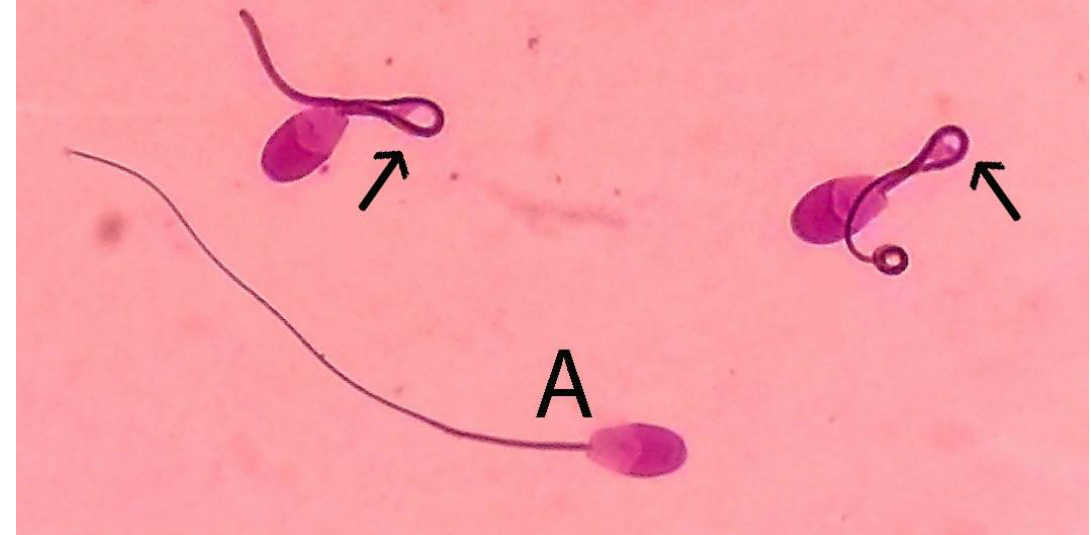
Figure 1. Spermatozoa after hypoosmotic swelling test. Arrow: hypoosmotic swelling test (HOST) positive spermatozoa that show signs of tail swelling; A: HOST negative spermatozoa without swelling.